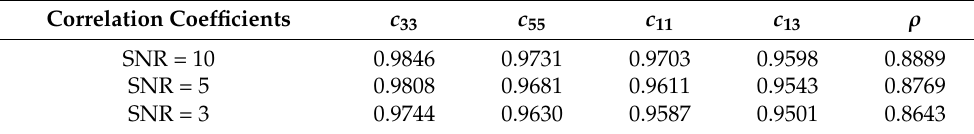
Figure 13. Inversion results of the proposed method by using the noisy angle gathers of Figure 12. to ( c ) and the result (red curve) in Figure 10c. The definitions of inverted curves are given in the legend. Table 3. Correlation coe ffi cients of the inversion results in Figure 13a–c and the true models.